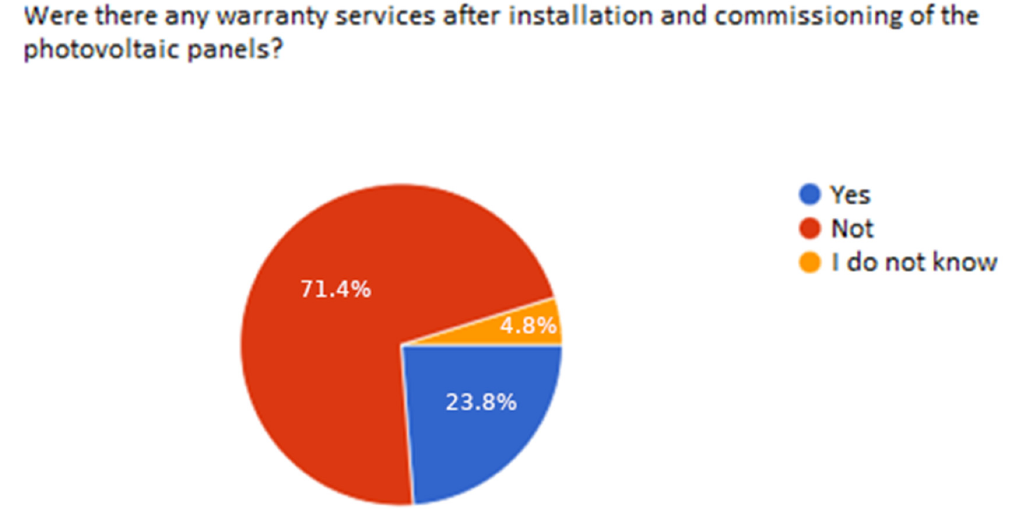
Figure 21. Warranty services.